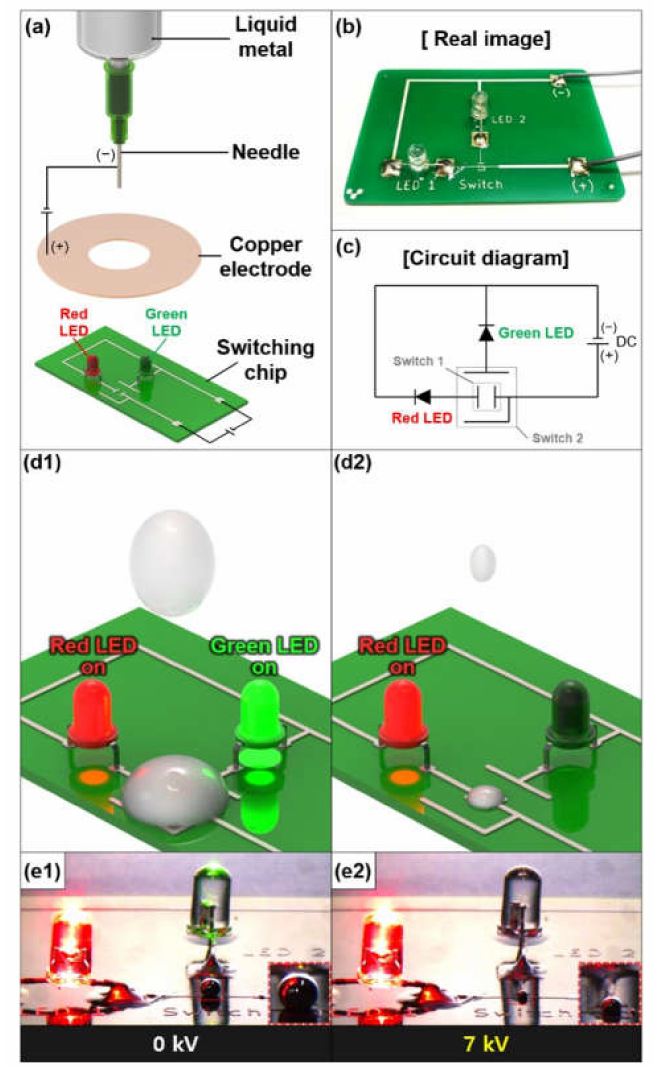
Figure 9. ( a ) Conceptual schematic of short circuit demonstration based on a volume control of the gallium-based liquid metal droplet using a circular-shaped Cu electrode with a hole and electrical circuit; ( b ) optical image; ( c ) diagram of fabricated electric circuit; ( d1,d2 ) conceptual schematic; and ( e1,e2 ) optical images of the switching application with and without 7 kV (multimedia